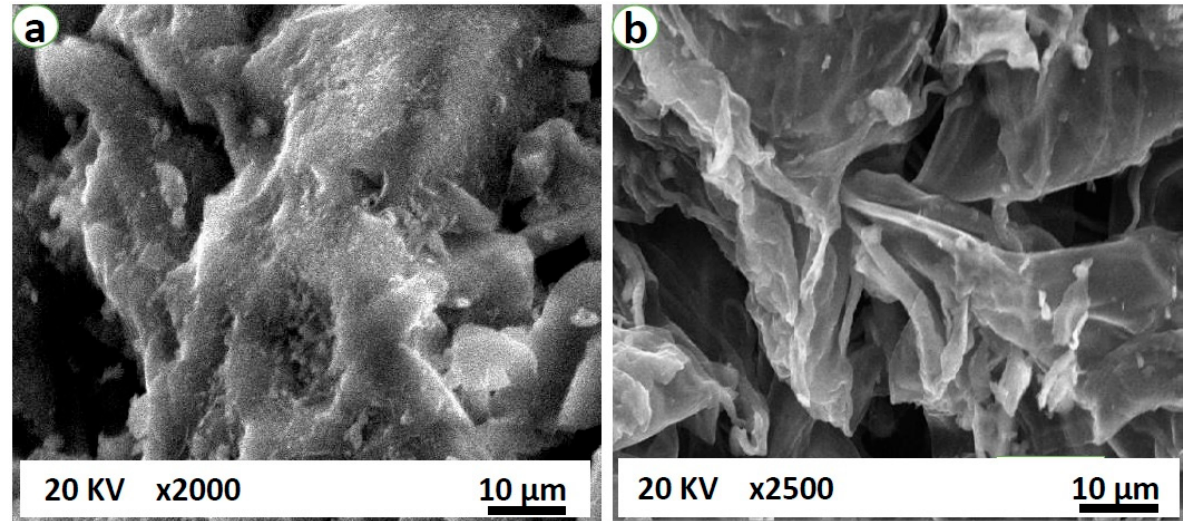
Figure 6. Morphological images of ( a ) silica gel type III and ( b ) the produced activated carbon.